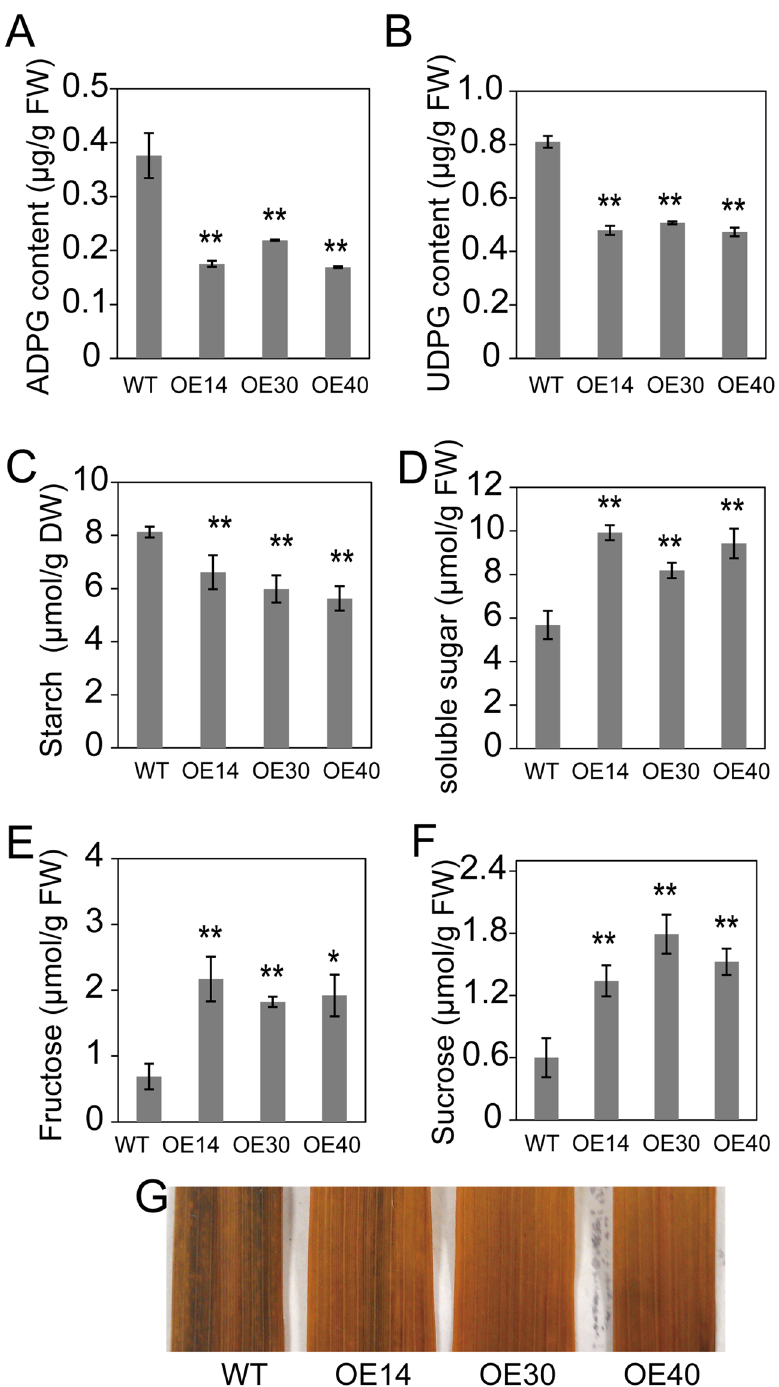
Figure 7. Overexpression of SQD2.2 resulted in reduced UDPG and ADPG content and decreased starch synthesis. ( A ) and ( B ) The ADPG and UDPG content in SQD2.2 -OE leaves was significantly lower than that in WT plants at the tillering stage. Values are the mean ± SE (n = 6). ( C ) to ( F ) Reduced starch and elevated soluble sugar levels in SQD2.2 -OE plants compared to WT plants. Samples were taken at the tillering stage. Values are the mean ± SE (n = 6). ( G ) Starch accumulation in leaves was visualized by KI-I 2 staining. Leaf pigments were removed by 96% ethanol, and then leaves were stained with iodine solution (2% KI, 1% I 2 ) for 30 min. Student’s t test; * P < 0.05, ** P <